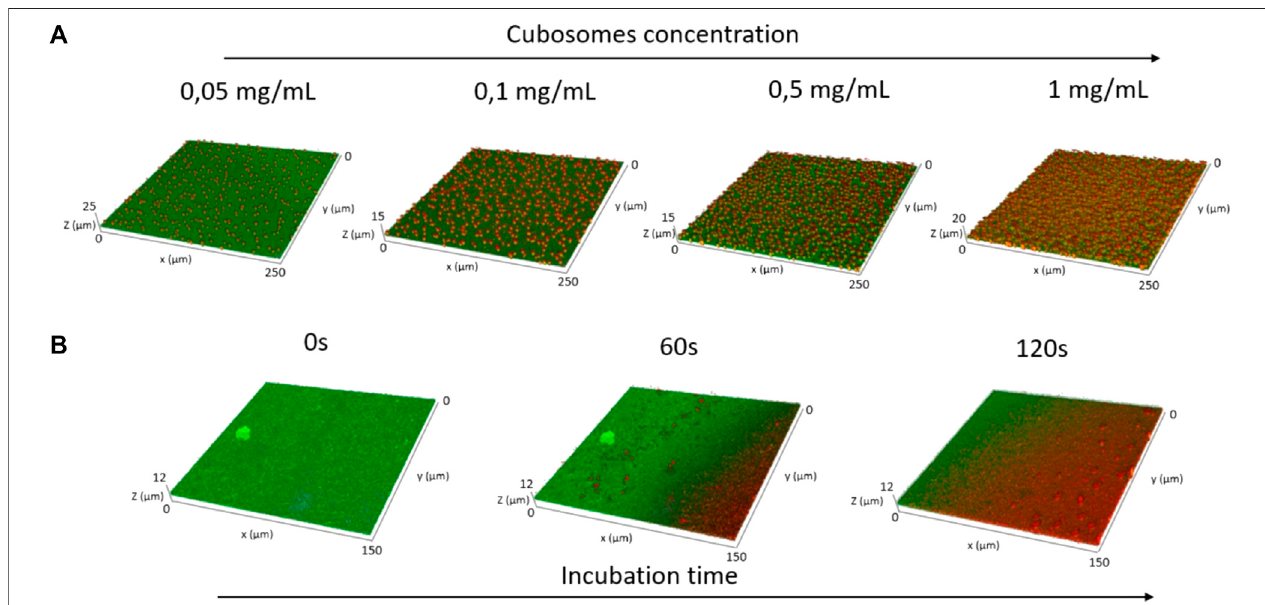
FIGURE 4 | Panel (A) : representative CLSM 3D reconstructions of the SLB/cubosomes systems, obtained after 30 min of incubation of the SLB with different concentrations of cubosomes (i.e. 0.05 mg/ml, 0.1 mg/ml, 0.5 mg/ml, and 1 mg/ml). Panel (B) : CLSM 3D reconstructions, representing the temporal evolution of the system obtained from the deposition of 0,05 mg/ml cubosomes on the SLB. The 3D reconstructions have been collected at 0s (i.e. before the addition of cubosomes), 60 s, and 120 s from the cubosomes ’ addition. DOPC/DOTAP SLB has been labelled with β -Bodipy ( λ exc 488 nm λ em, 493 – 614 nm) while stabilizer-free GMO-